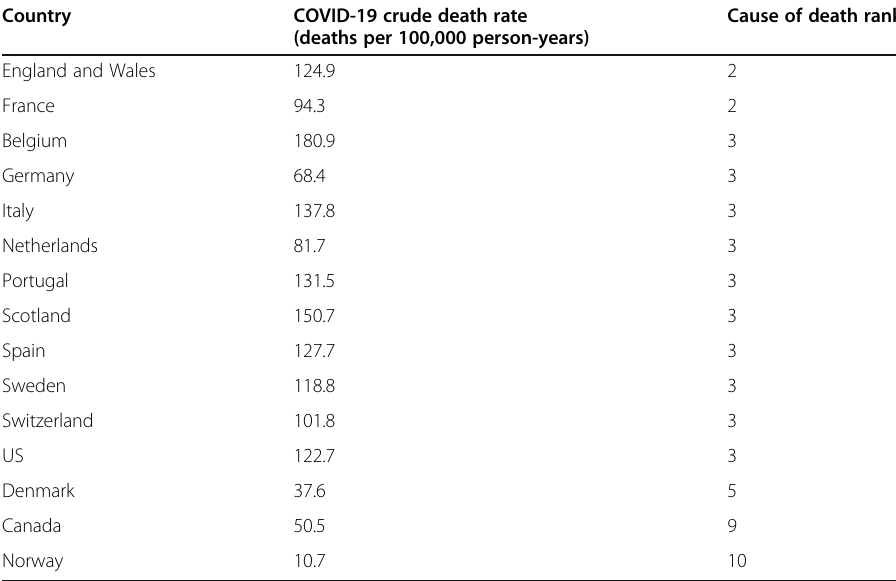
Table 1 COVID-19 crude death rate and rank among leading causes of death Country COVID-19 crude death rate Cause of death rank (deaths per 100,000 person-years) England and Wales 124.9 2 94.3